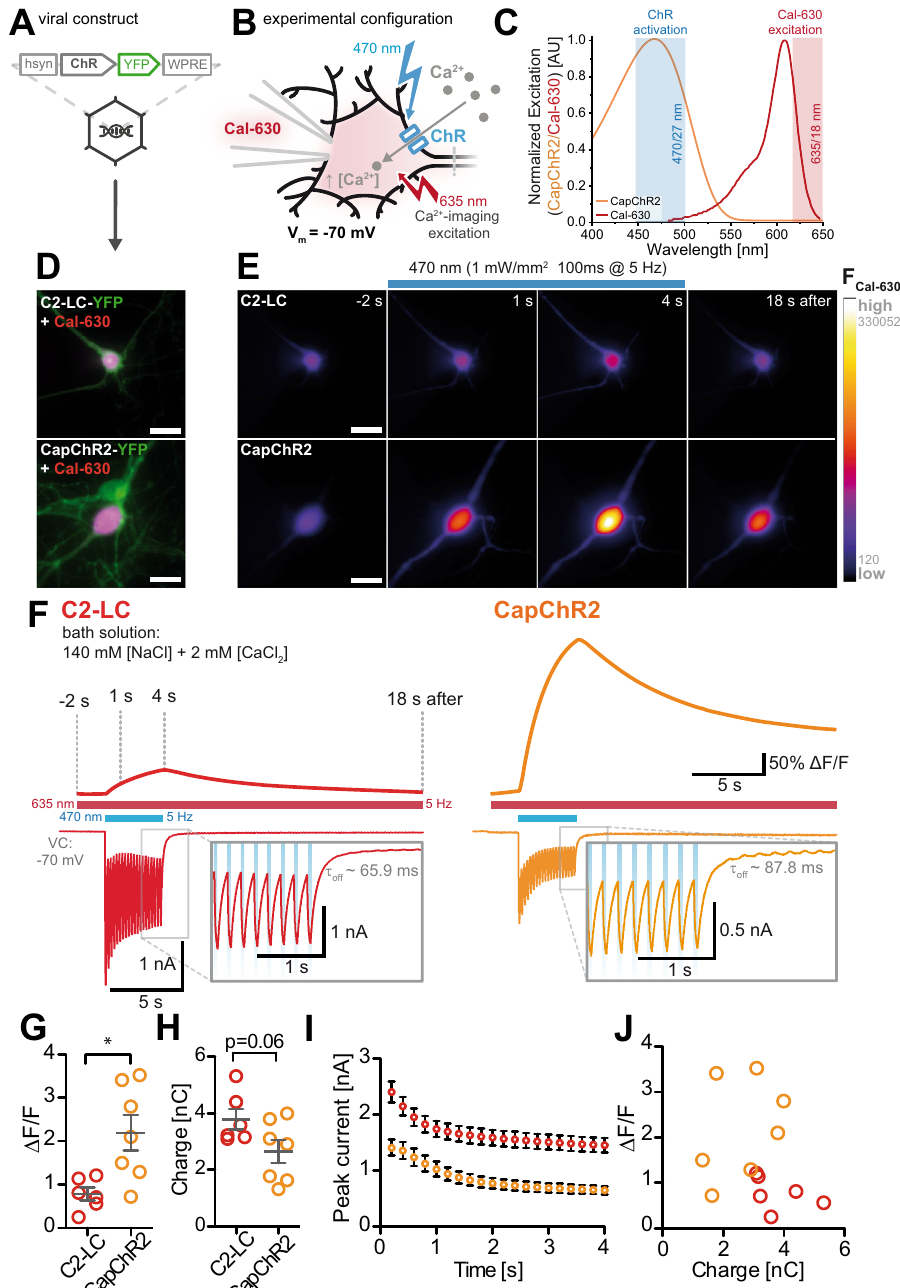
Fig. 5 | Quanti fi cation of light-driven Ca 2+ fl ux in neurons. A Design of the AAV- expression vector with YFP fused to the opsins. B Whole-cell voltage-clamp experiments allowed direct perfusion of the Cal-630 indicator, with high loading ef fi ciency in the soma. C Exemplary activation spectra of CapChR2, the excitation spectrum of Cal-630 and the band-pass fi ltered light for ChR and Cal-630 excita- tion. CapChR2 action spectra reproduced from Supplementary Fig. 10, with n =6, the excitation spectrum of Cal-630 provided by the manufacturer. D Exemplary live-cell wide- fi eld images of neurons expressing C2-LC-YFP or CapChR2-YFP, overlaid with a maximum intensity projection of the Cal-630 signal obtained dur- ing the recording session (scale bars: 10 µ m). E Fluorescent images of the Cal-630 signal before ( − 2s), after 1 or 4s of blue light fl ashes, or 18s after blue-light illu- mination from the cells shown in C (scale bars: 10 µ m). F Single-trial intensity